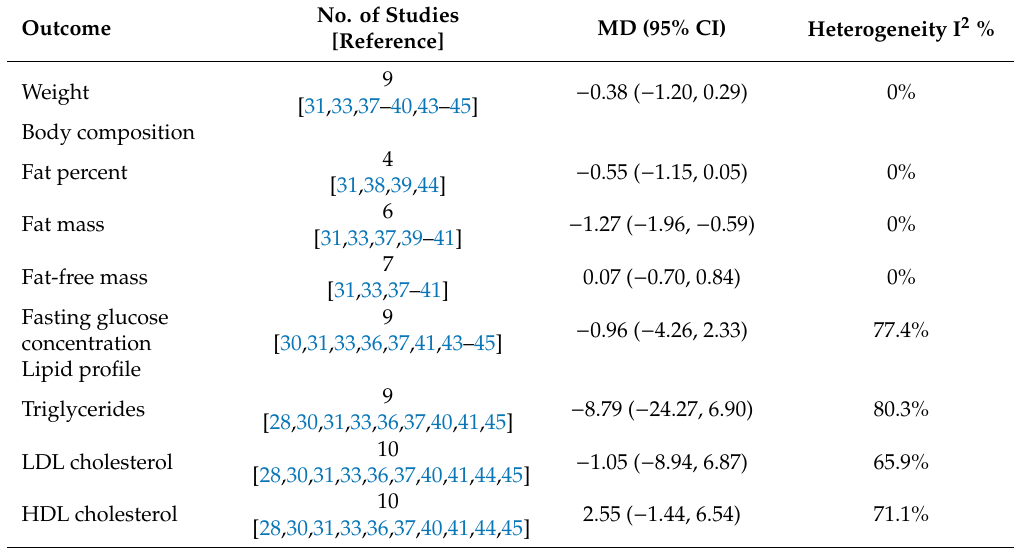
Table 3. Meta-analyses with clinical trial studies compared to the control